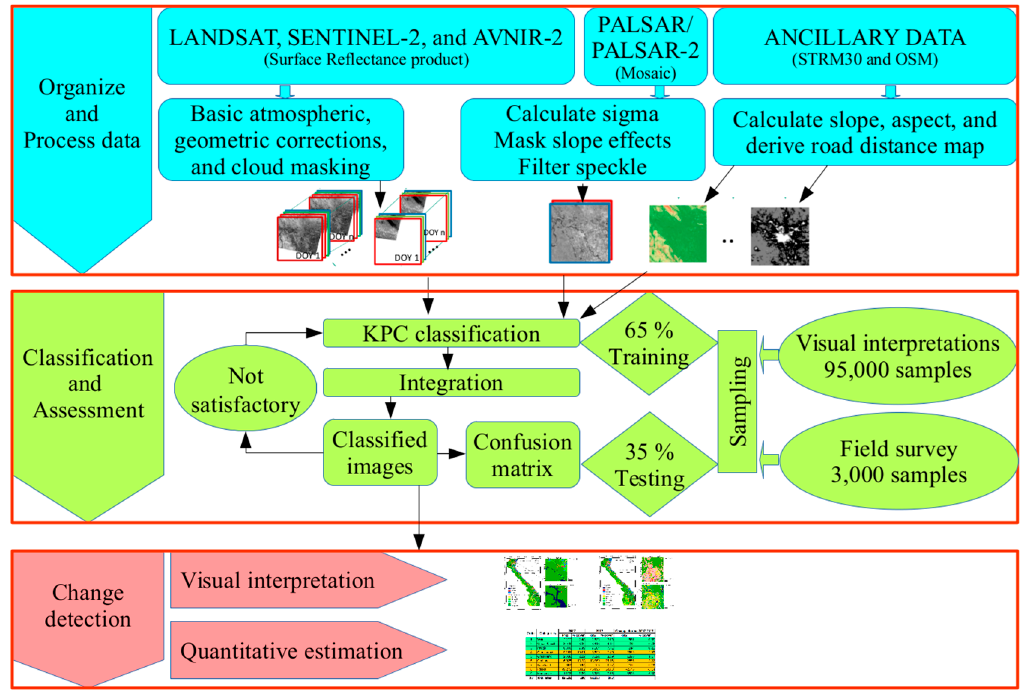
Figure 2. Overall flowchart of land cover/use change monitoring and analysis in this study.